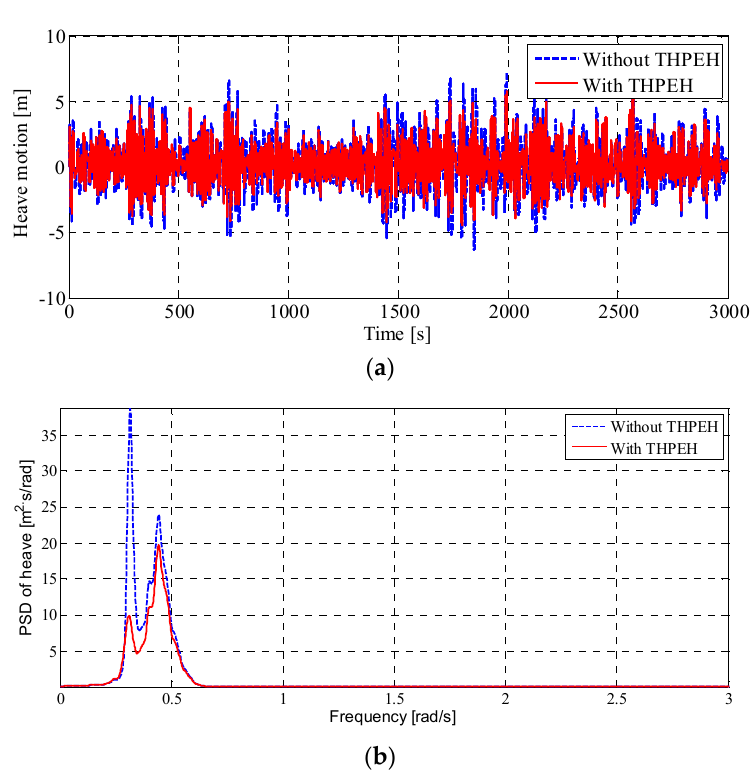
Figure 16. ( a ) The time histories of the heave motion with and without the THPEH system under IRW ‐ 1; ( b ) the power spectra of the heave motion with and without the THPEH system under IRW ‐ 1.